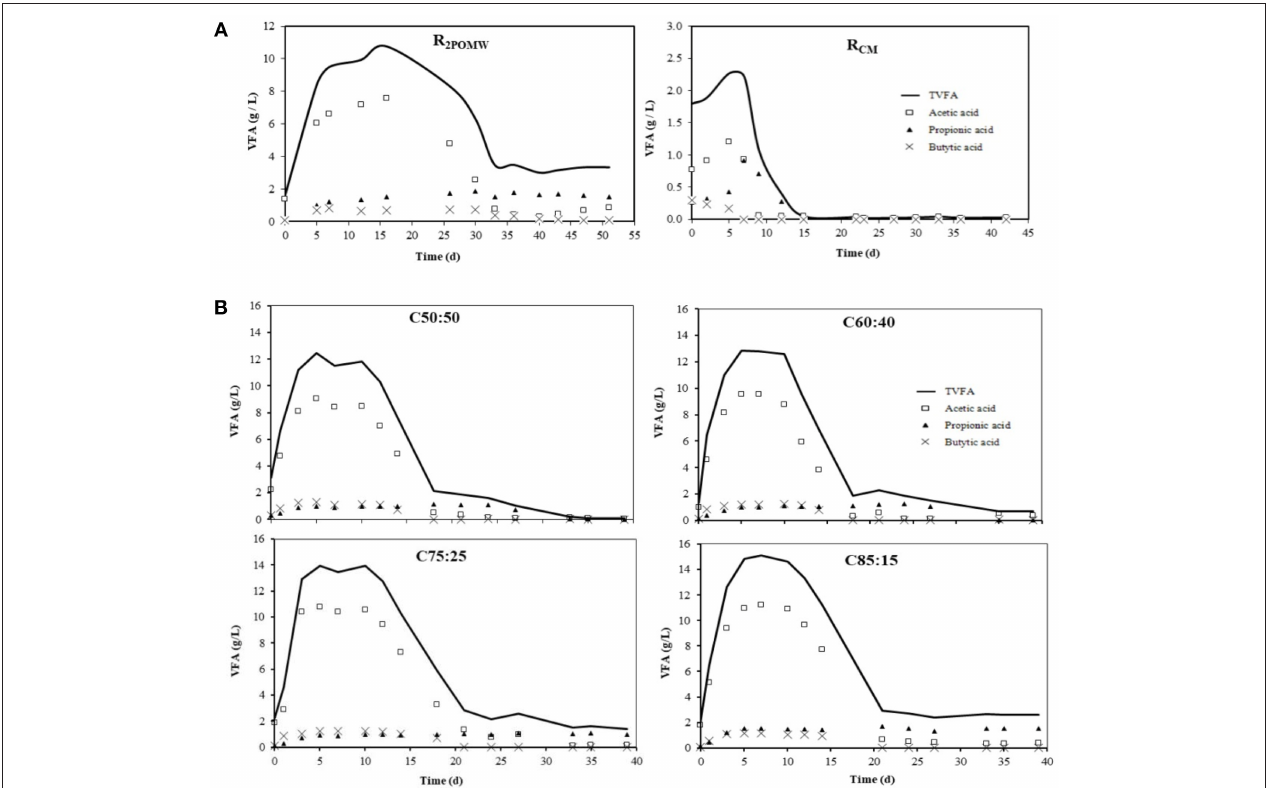
FIGURE 4 | Total VFA and individual VFA evolution (acetic, propionic and butyric acid) for co-substrates (A) and mixtures of co-digestion (B) .